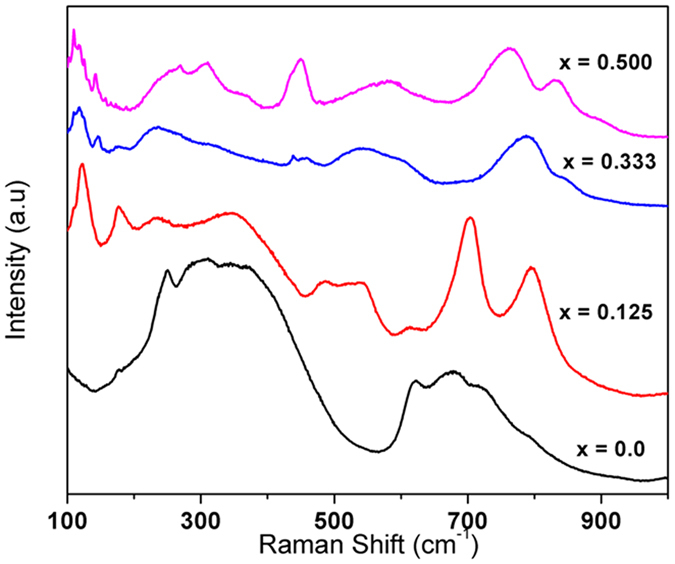
Raman spectra of SrTi1−2xFexTaxO3 compositions (x = 0.0, 0.125, 0.33 and 0.50).